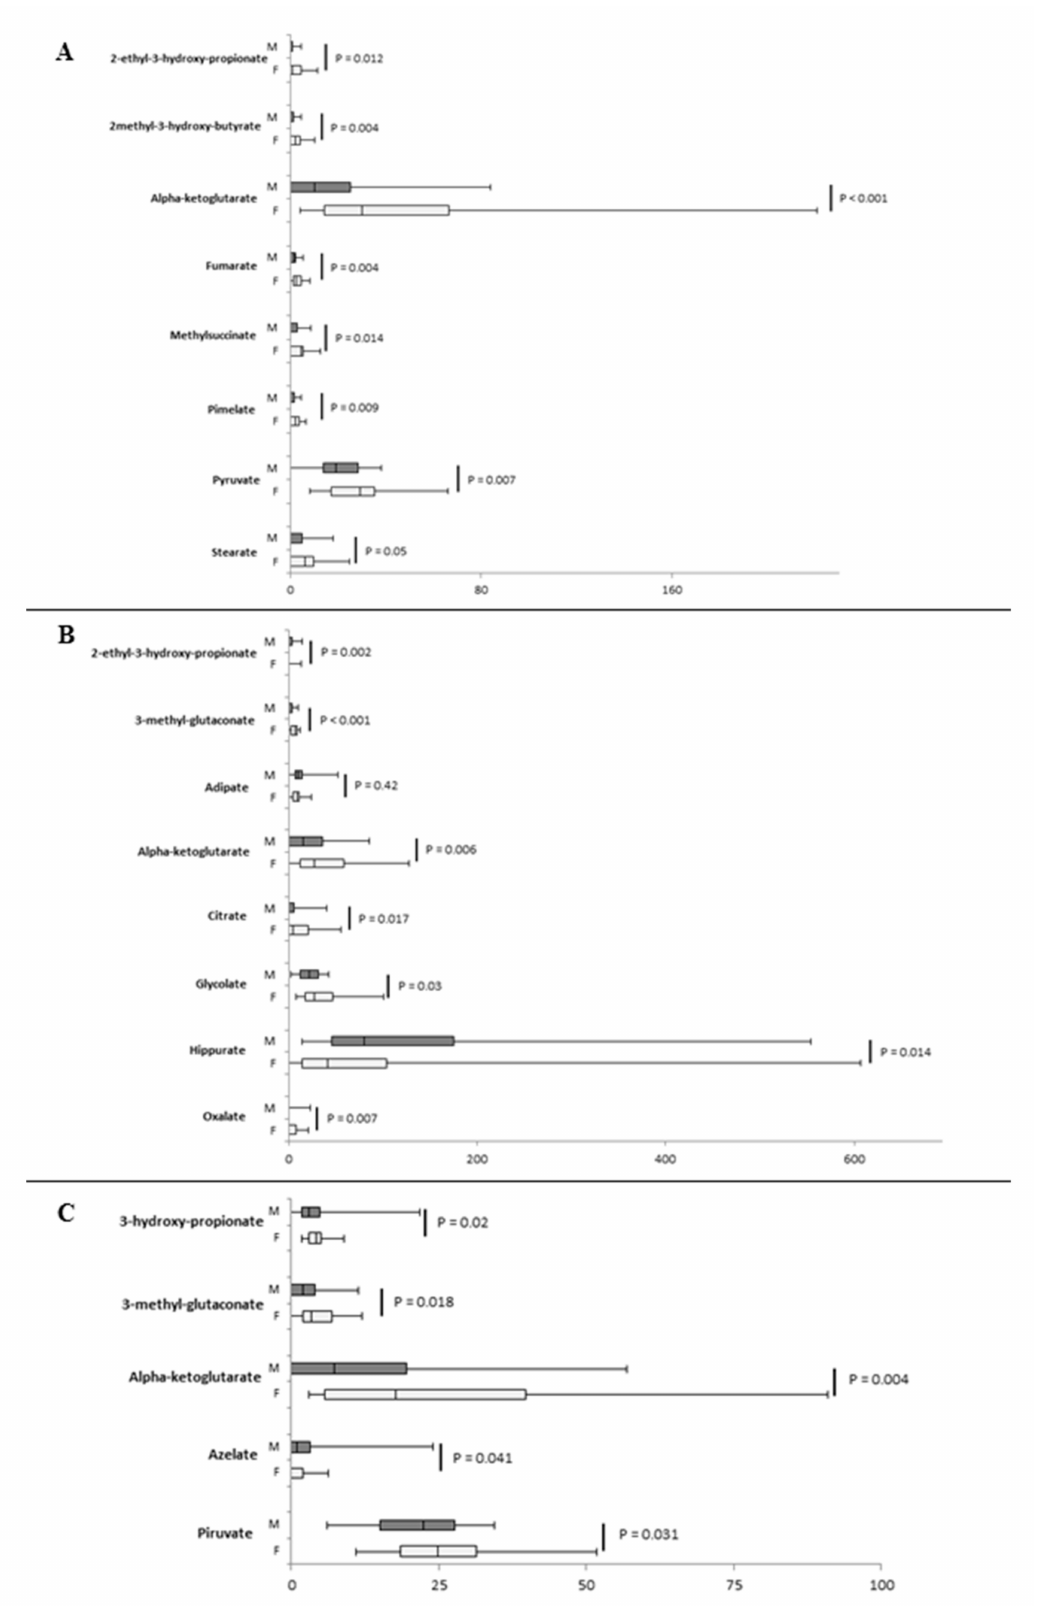
Figure 5. Box plot of urinary organic acids, which displayed a sex di ff erence in age groups 2 ( A ), 3 ( B ), and 4 ( C ). Values are expressed as mmol / mol of creatinine. The vertical line across the box represents the median, and the box comprises the first and the third quartiles. The horizontal lines represent the minimum and the maximum values. Sample size for each group is reported in Tables S2 and